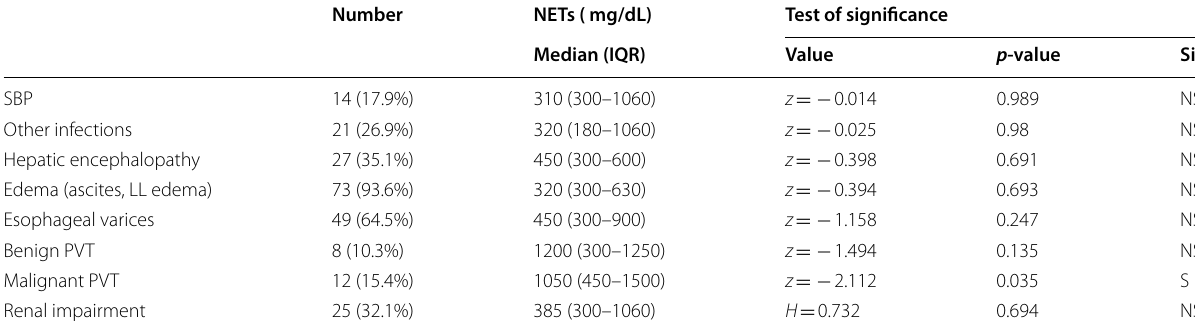
Table 5 Relation between NETs and complication of the